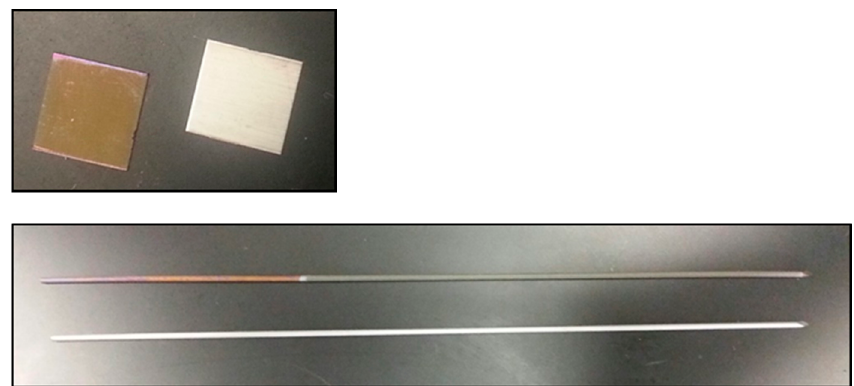
Figure A1. Digital photographs showing the final appearance of 10 mm × 10 mm coupon samples (top) and Kirschner wires (bottom). TiNT-etched surfaces appear golden and smooth, compared to unmodified control surfaces.